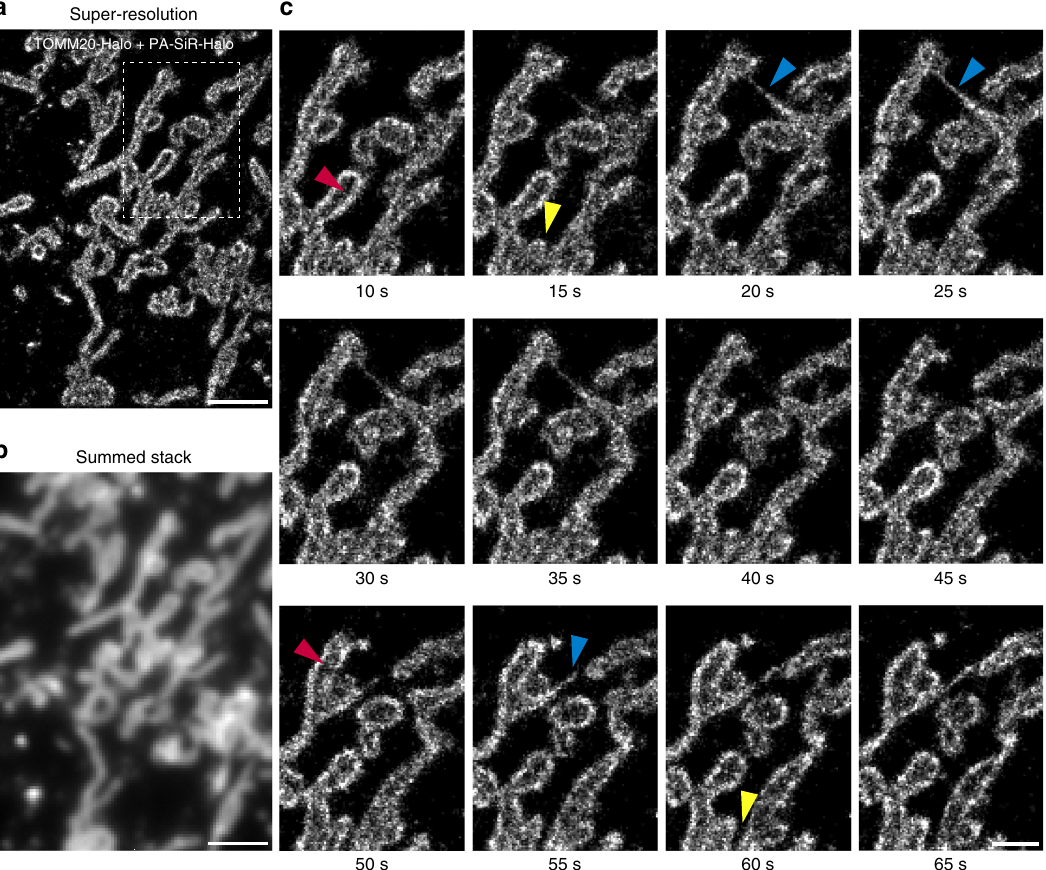
Fig. 4 Live-cell SMLM of the outer mitochondrial membrane (TOMM20-Halo) labeled with PA-SiR-Halo. a Super-resolved image acquired within 10 s (50 ms exposure time, 0.3 kW cm − 2 642 nm excitation). The recently published ImageJ plugin HAWK 71 was used to achieve imaging at high emitter densities to capture fast structural changes. b Sum projection over the fi rst 10 s mimicking the diffraction limited image. Scale bar, 2 μ m. c Time series of boxed region in ( a ). Each frame is reconstructed from 200 frames (10 s). For clarity, snapshots are shown only every 5 s. Several mitochondria are perceived to be hollow as Tomm20 is localized to the outer membrane of mitochondria (red arrowheads). The highly dynamic mitochondria form thin tubules between neighboring mitochondria (blue arrowheads) and disconnect ( fi ssion) in other areas (yellow arrowheads). Scale bar, 1 μ m. Full